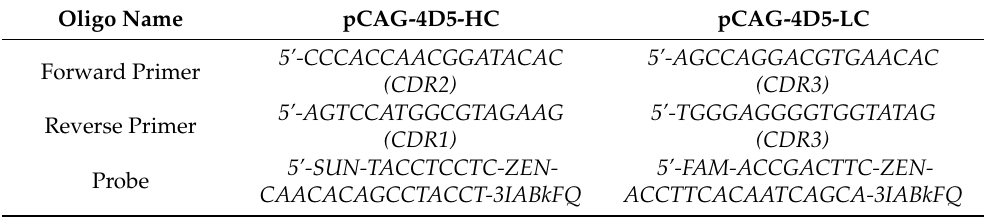
Table 1. Primer and probe sequences qPCR assay pCAG-4D5-HC and pCAG-4D5-LC purchased from Integrated DNA Technologies (IDT, Leuven, Belgium). Specific binding regions are indicated between